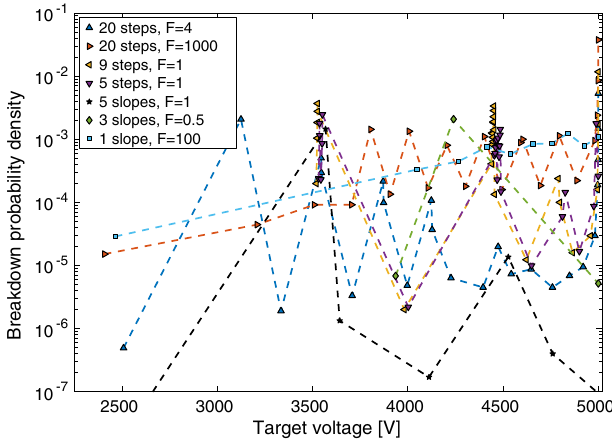
and sBD , for sBD